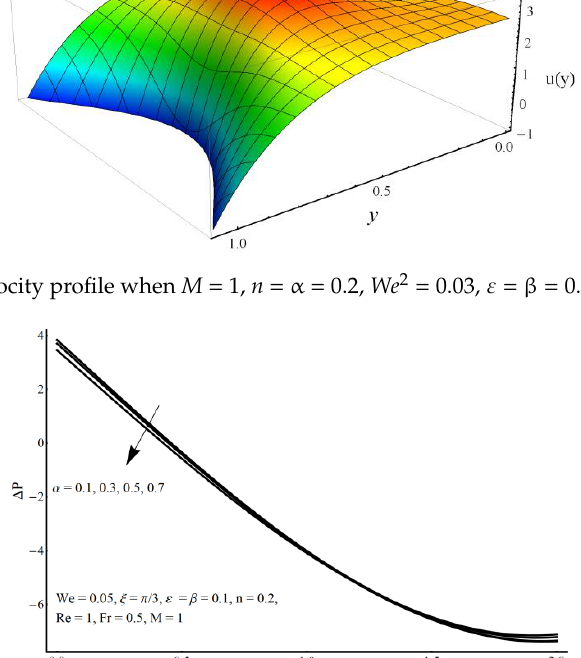
Figure 5. Pressure rise per wavelength at various values of α.